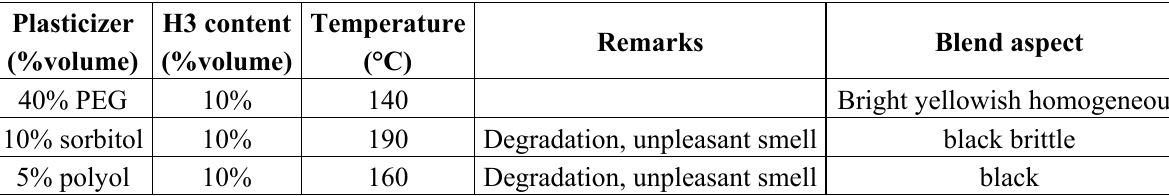
Table 3. Polymer Blend composites: preparation conditions and results (SPSFNa, IEC = 1.35 Na +